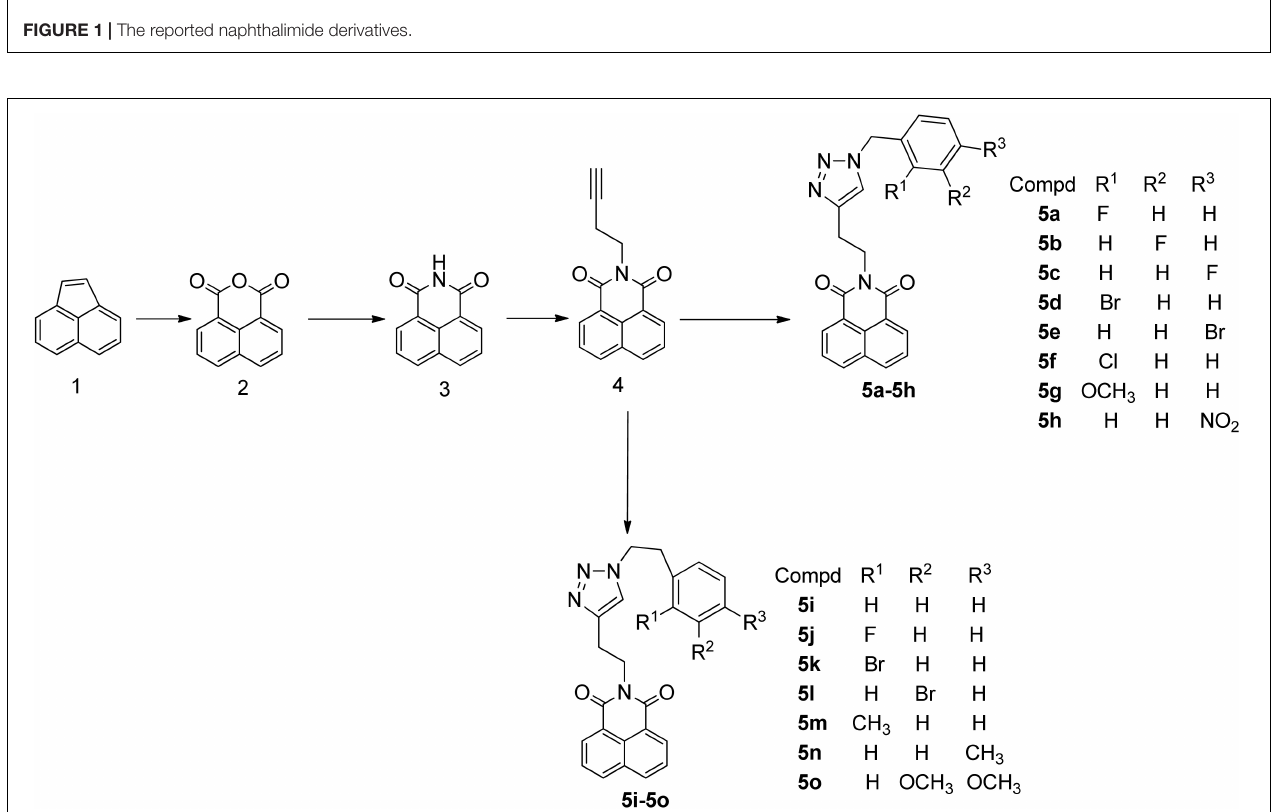
SCHEME 1 | Reaction routes for the production of the target compounds.